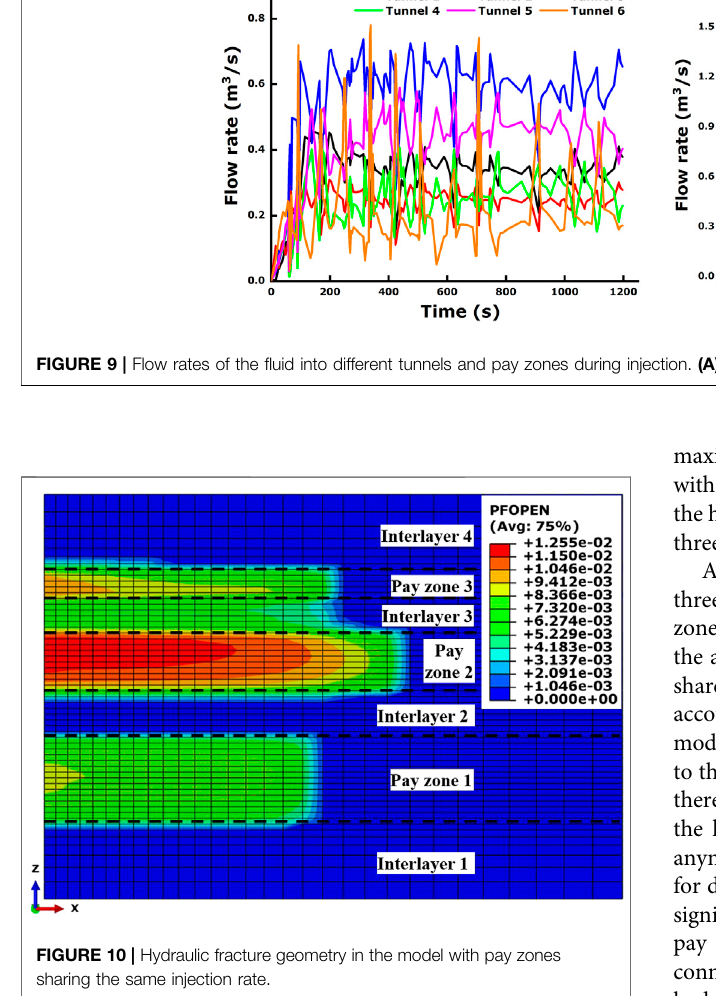
Frontiers in Earth Science |